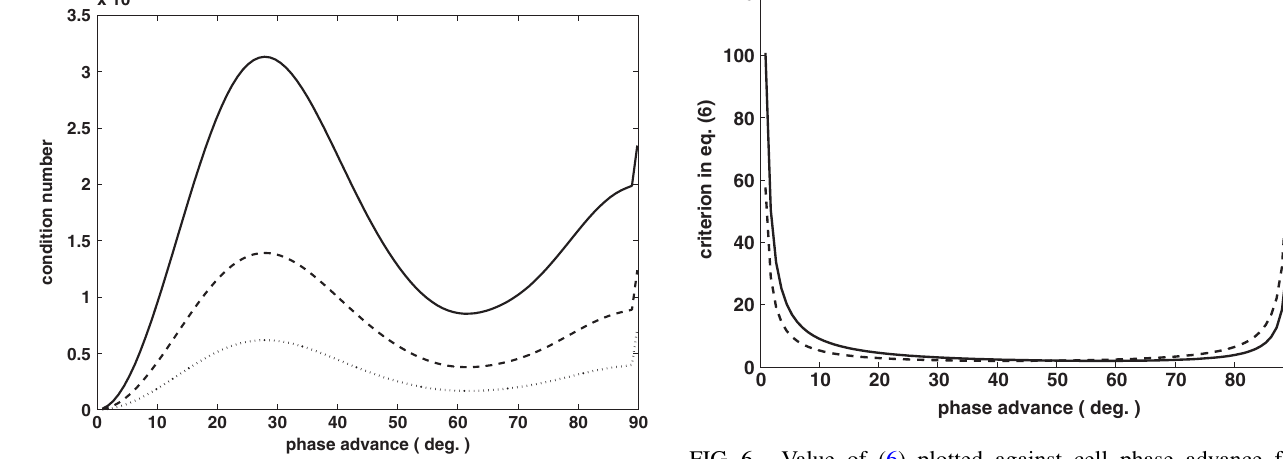
FIG. 4. Condition number of M phase advance for (cid:6) -function 90 m (solid line), 60 m (dashed line), and 40 m (dotted line). 3 wire scanners.